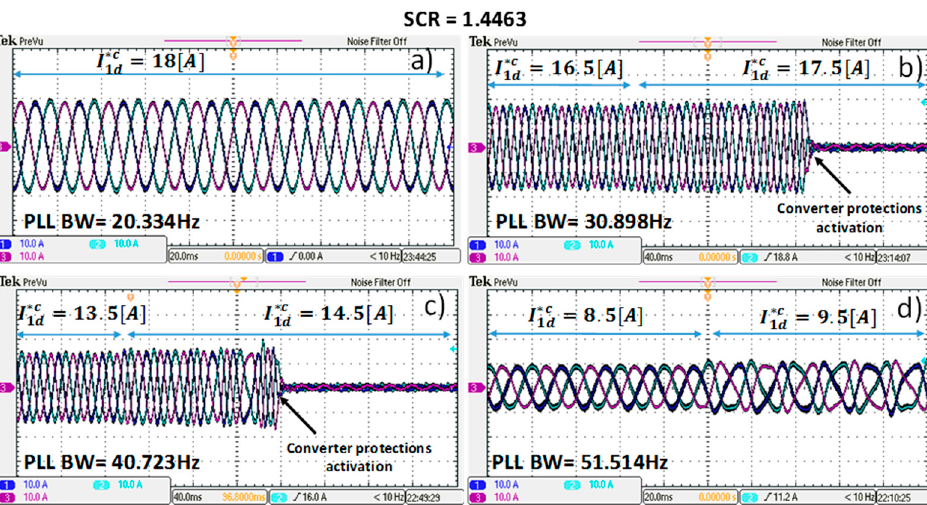
Figure 13. Experimental results: ( a ) Maximum active current injected into the grid with PLL bandwidth of 20.334 Hz (10 A/div); ( b ) Maximum active current with PLL bandwidth of 30.898 Hz (10 A/div); ( c ) Maximum active current with PLL bandwidth of 40.723 Hz (10 A/div); ( d ) Maximum active current with PLL bandwidth of 51.514 Hz (10 A/div).